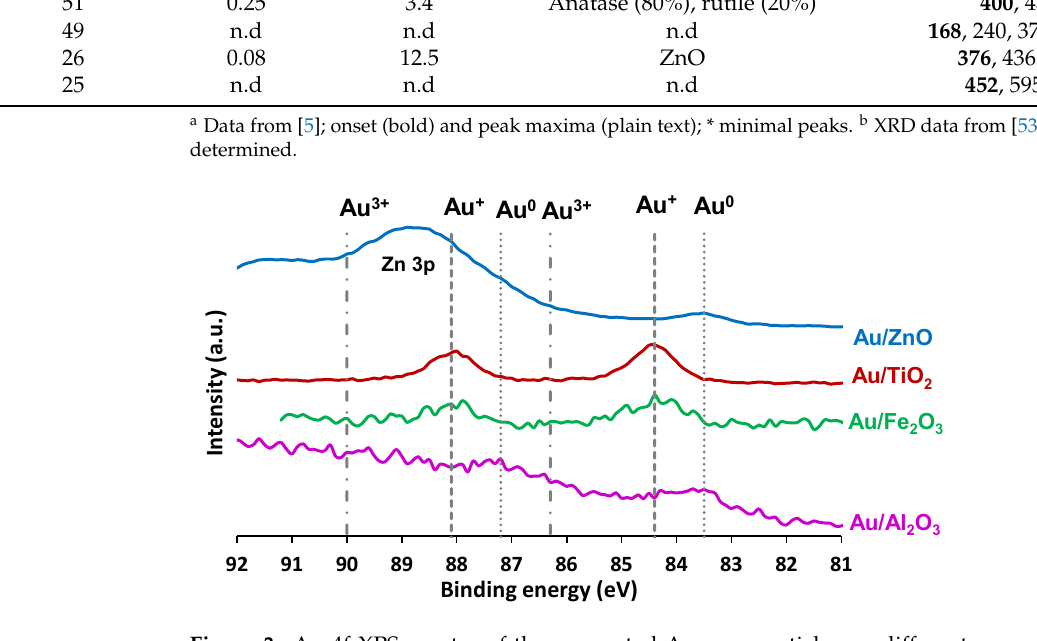
Figure 2. TPR profiles of supports and Au samples: ( a ) Al 2 O 3 , ( b ) Fe 2 O 3 , ( c ) TiO 2 , ( d ) ZnO. Adapted from [5] with permission from Wiley.